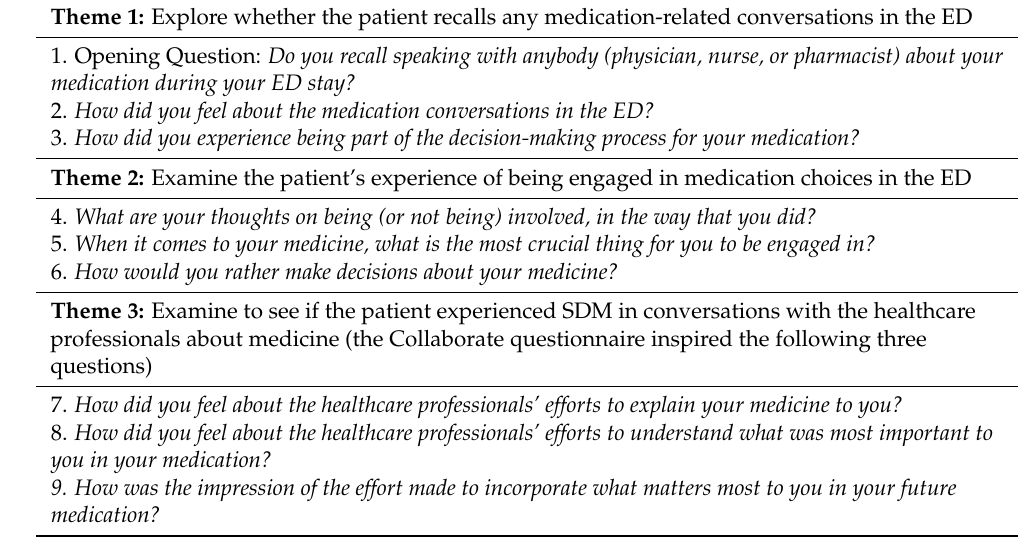
Table 2. Semi-structured interview guide used in the qualitative